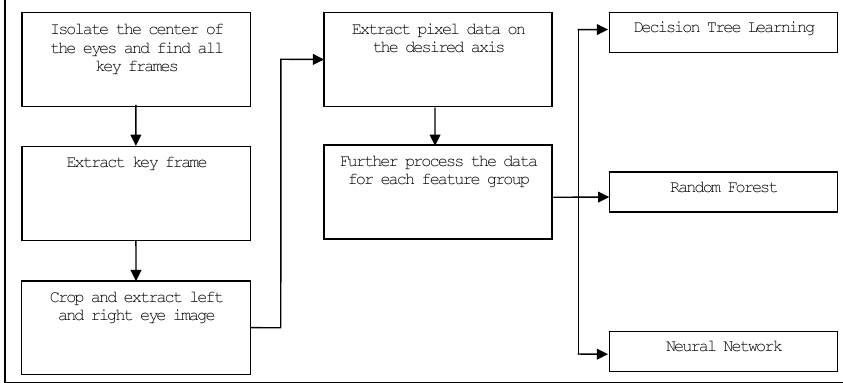
Figure 2. The feature extraction